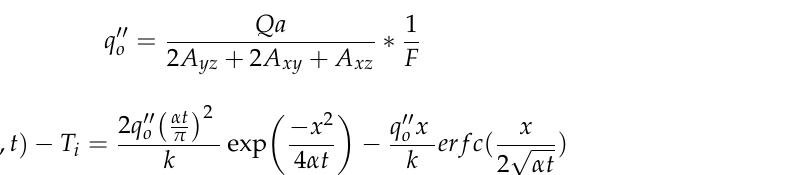
Figure 9. Scanning Electron Microscope (SEM) image with a laser power of 250 W.